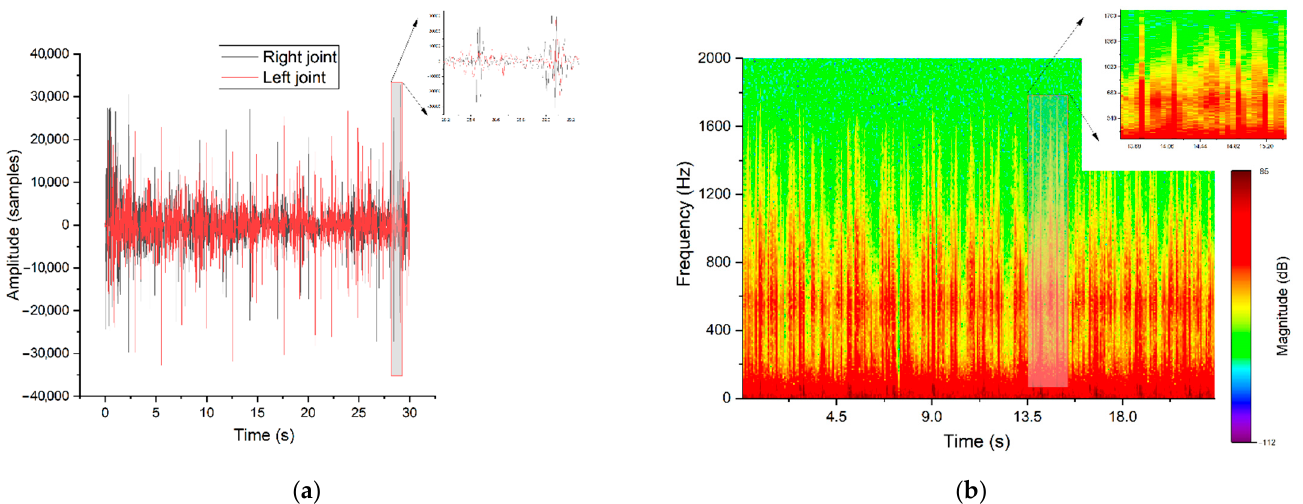
Figure 5. Signals traces recorded on both sides in the time domain ( a ) and STFT representation of TMJH manifested as a high-amplitude double-peak waveform ( b )—representative parts of one jaw movement were magnified.